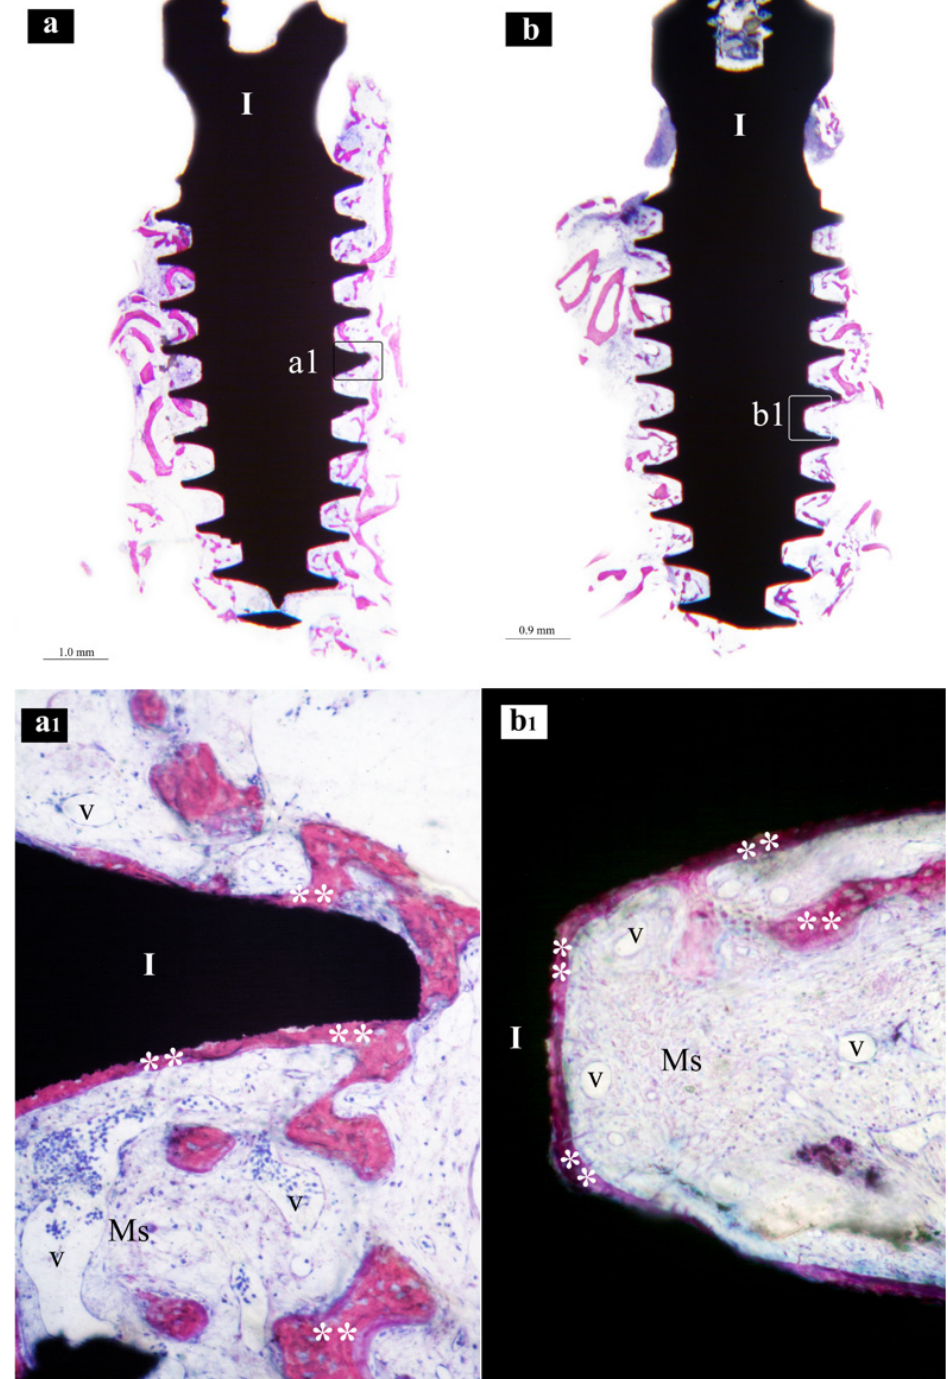
Figure 3. Central sections of two implants of the SLA group after 4 weeks of healing. In ( a , b ), original magnifications (×12), the implant bodies (I), mainly in the threaded regions, appear to be partially surrounded by mineralized bone. In ( a1 ), original magnifications (×200), the implant threads (I) appear to be surrounded by newly formed bone (**), while in the marrow spaces (Ms) several vessels (v) in section are visible. In ( b1 ), original magnifications (×200), the implants (I) in the inter-thread space newly formed bone (**) appears to be formed in contact with the implant surface, while in the marrow spaces (Ms) several vessels (v) are visible.